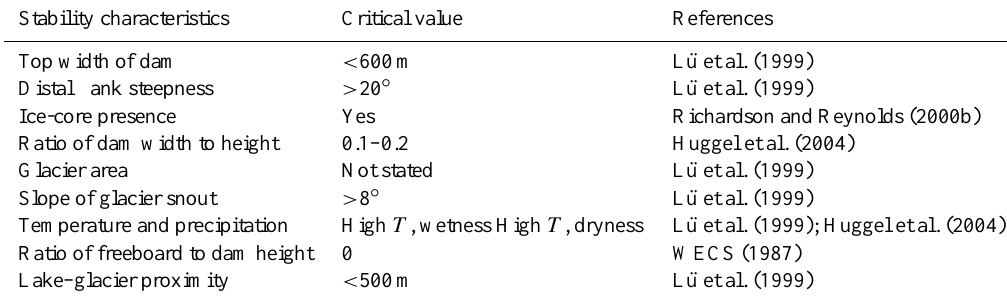
Table 5. The stability characteristics and their critical values defined by Wang et al.